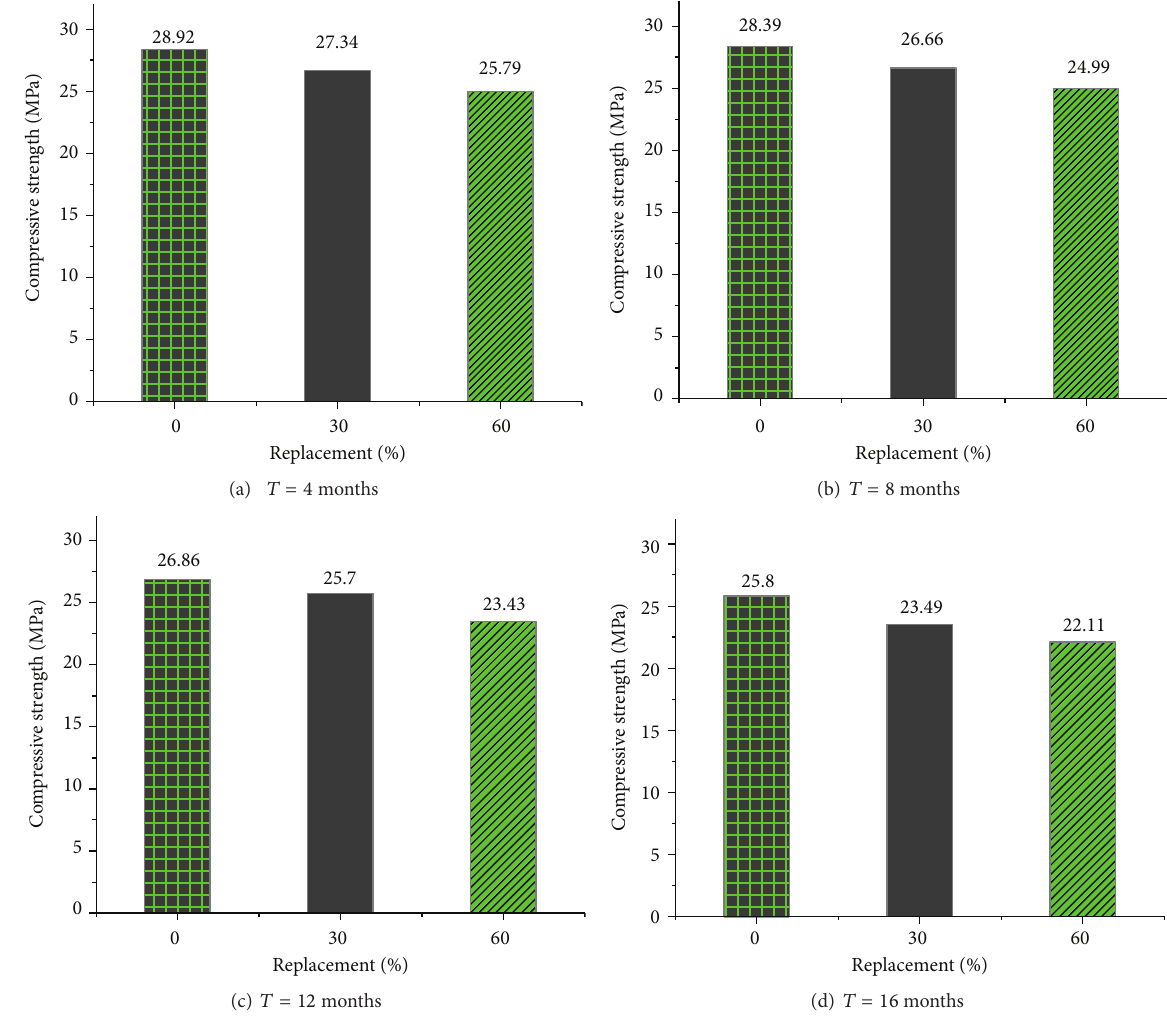
Figure 3: Compressive strength of RC in marine